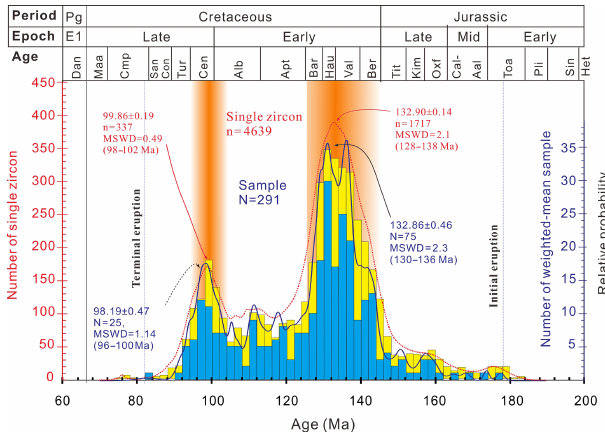
Figure 3. Diagram showing U–Pb isotope age relative proba- bility and histogram of both single zircon and individual sam- ple weighted-mean zircons from all extrusive rock samples in SE China. N : number of rock samples; n : total number of zircon